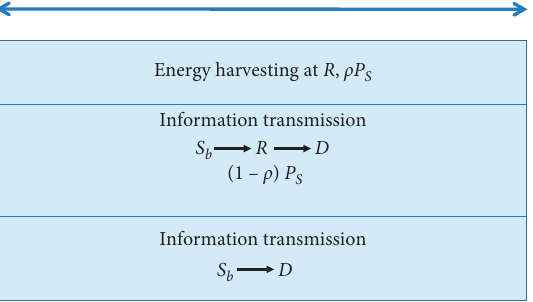
Figure 2: IT and EH